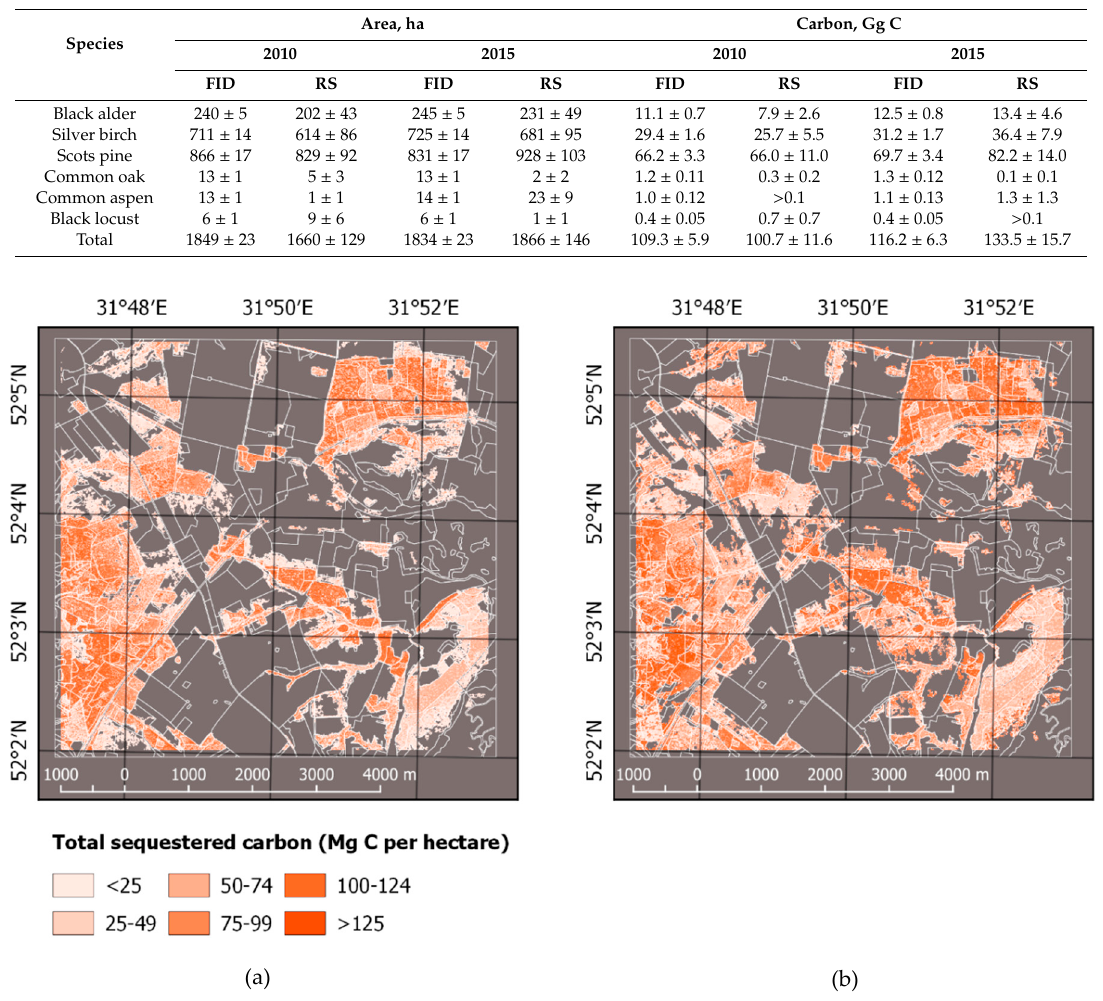
Figure 3. Carbon stock of forest ecosystems predicted by k -Nearest Neighbors method using satellite images: ( a ) RapidEye image for 2010; ( b ) SPOT 6 image for 2015. Forest loss (Table 9) is identified within forested areas disturbed by natural agents (a wildfire in